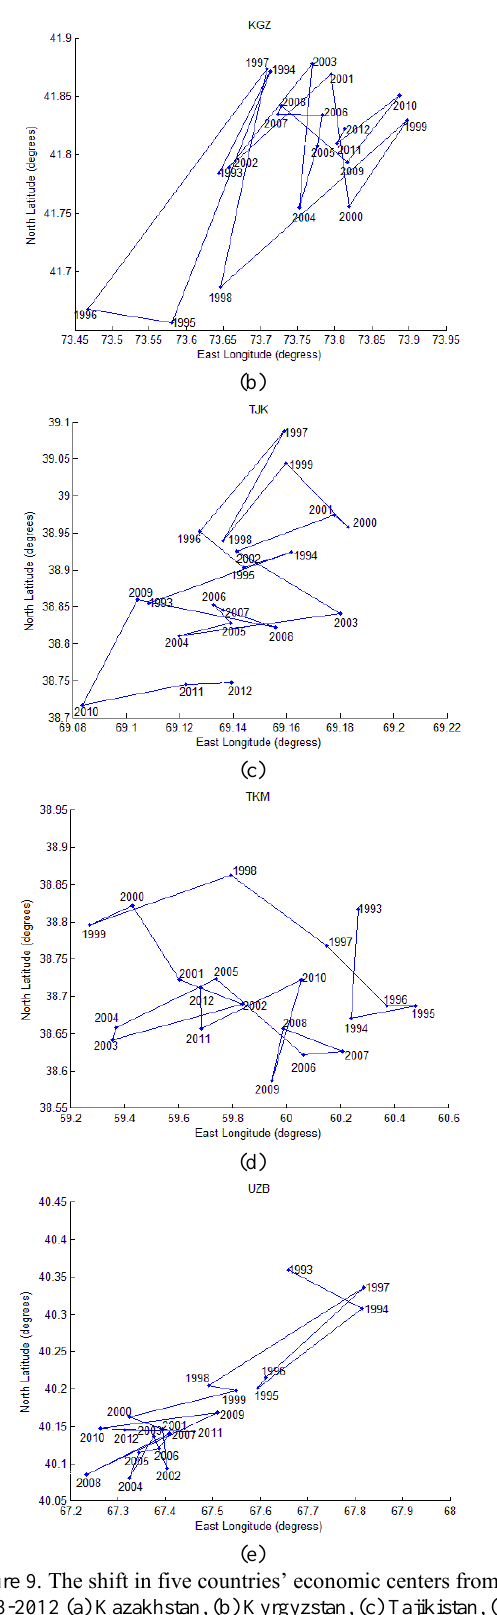
Figure 9. The shift in five countries’ economic centers from 1993-2012 (a) Kazakhstan, (b) Kyrgyzstan, (c) Tajikistan, (d) Turkmenistan, (e) Uzbekistan It can be seen that in Kazakhstan, the mean center of the standard deviation ellipse moved to the west from 1993 to 2006, and moved eastward from 2007-2012. In Kyrgyzstan, the mean center of the standard deviation ellipse moved north and